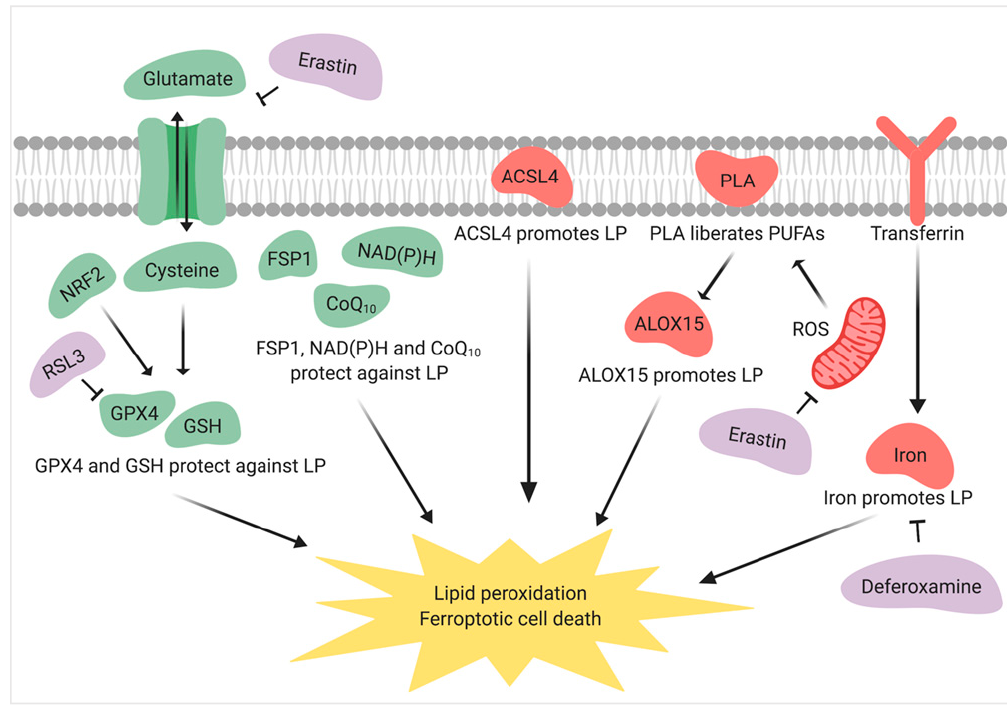
Figure 1. Key hallmarks of the ferroptotic pathway of cell death. Green and red indicate protectors and promoters of ferroptosis, respectively. Purple indicates chemical modulators of the ferroptosis pathway. Lipid peroxidation (LP) commonly occurs following the excessive production of mitochondrial reactive oxygen species (ROS). ROS activate phospholipase (PLA) enzymes, which then assist in the cleavage of poly-unsaturated fatty acids (PUFAs) from membrane phospholipids. Liberated PUFAs are